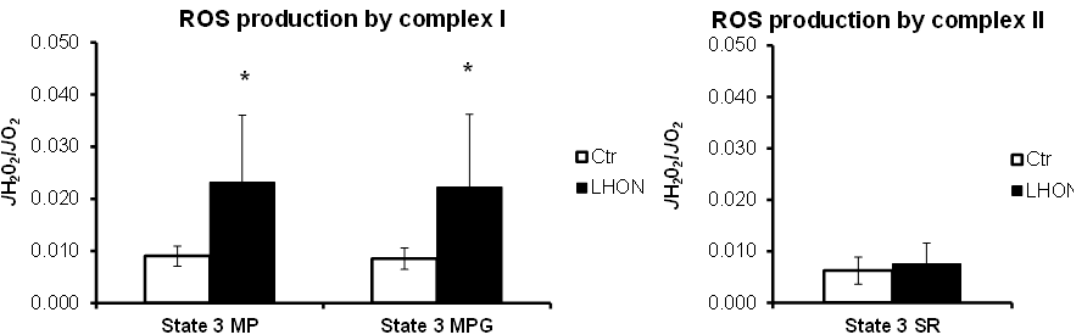
Figure 2. LHON and control fibroblast ROS production. ROS production was measured simultaneously with oxygen consumption using the O2k-Fluorometer equipped with two-channel fluorescence optical setup to monitor oxygen level and fluorescence. State 3 MP: maximal phosphorylating respiration with Complex I substrates malate (5 mM) and pyruvate (2.5 mM). State 3 MPG: maximal phosphorylating respiration with Complex I substrates malate (5 mM), pyruvate (2.5 mM), and glutamate (5 mM). State 3 SR: maximal phosphorylating respiration with Complex II substrate succinate (10 mM) and Complex I inhibited by rotenone (5 μ M). Statistical significance *: p < 0.05.